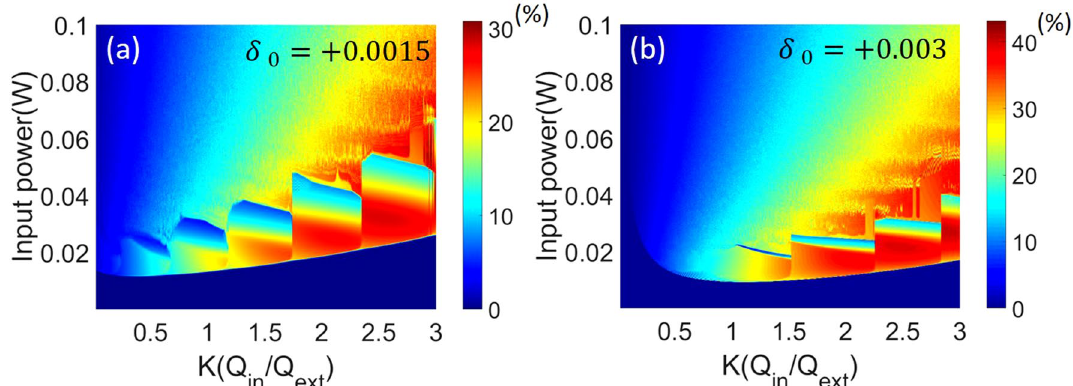
Figure 5. Conversion efficiency color-maps of the coupling and the input power at detuning ( a ) δ 0 = + 0.0015 and ( b ) δ